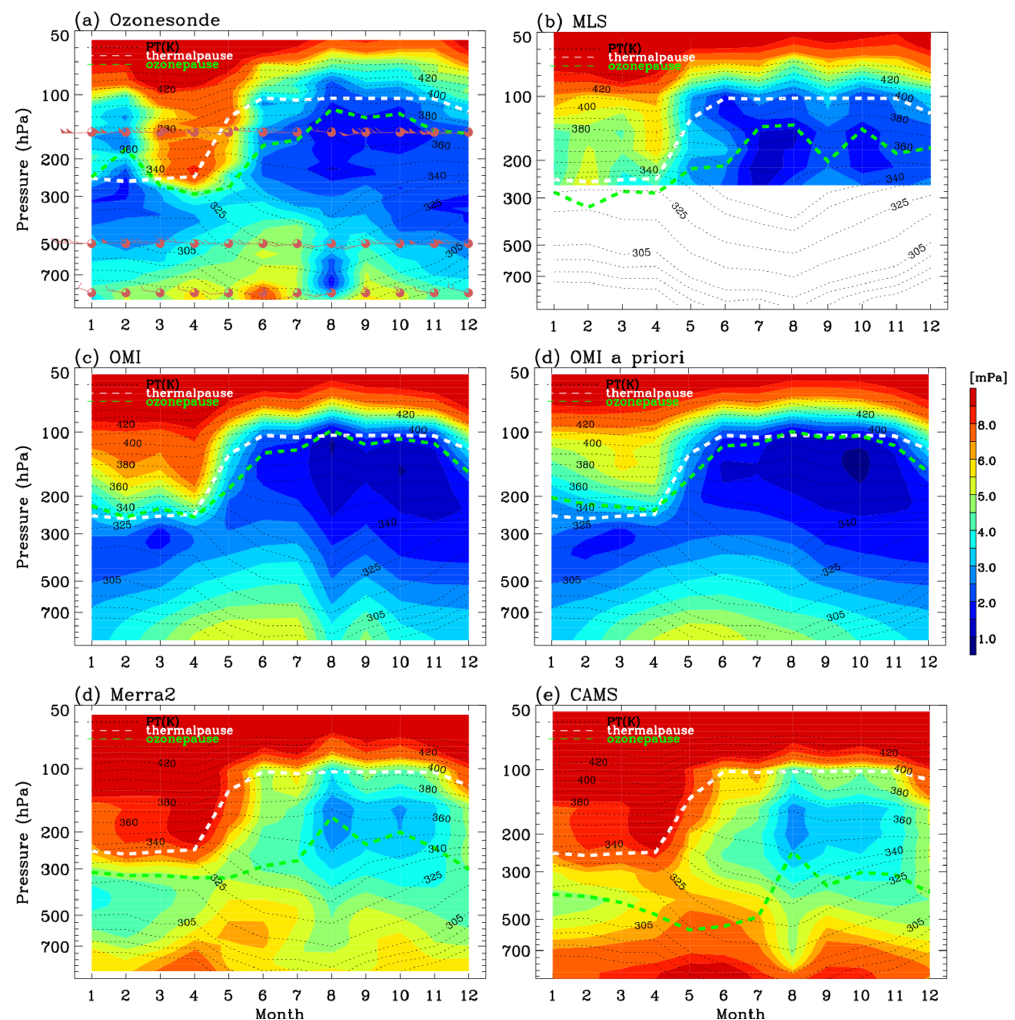
Figure 5. Contour plots of monthly ozone profiles in 2020 from (a) ozonesonde, (b) MLS, (c) OMI, (d) OMI a priori, (e) MERRA-2, and (f) CAMS. The meteorological variables are superimposed for wind barbs (red symbols), potential temperatures (black contours), and thermal tropopause heights (white lines) using monthly MERRA-2 meteorological data. The ozone value of 150ppb is plotted with green lines to indicate the chemical transition between the troposphere and